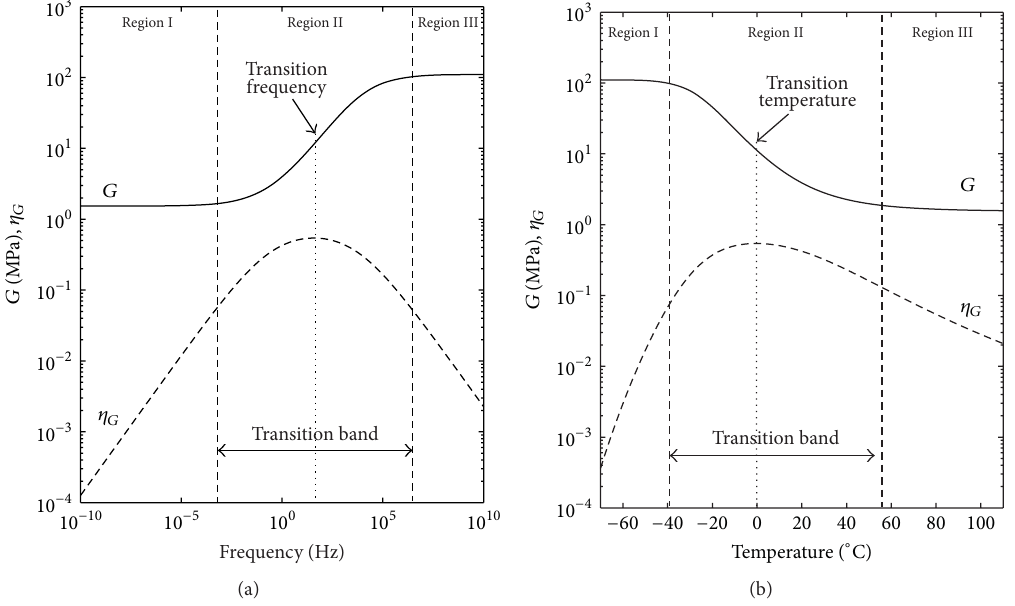
Figure 2: Dynamic shear modulus and loss factor as functions of (a) frequency and (b)